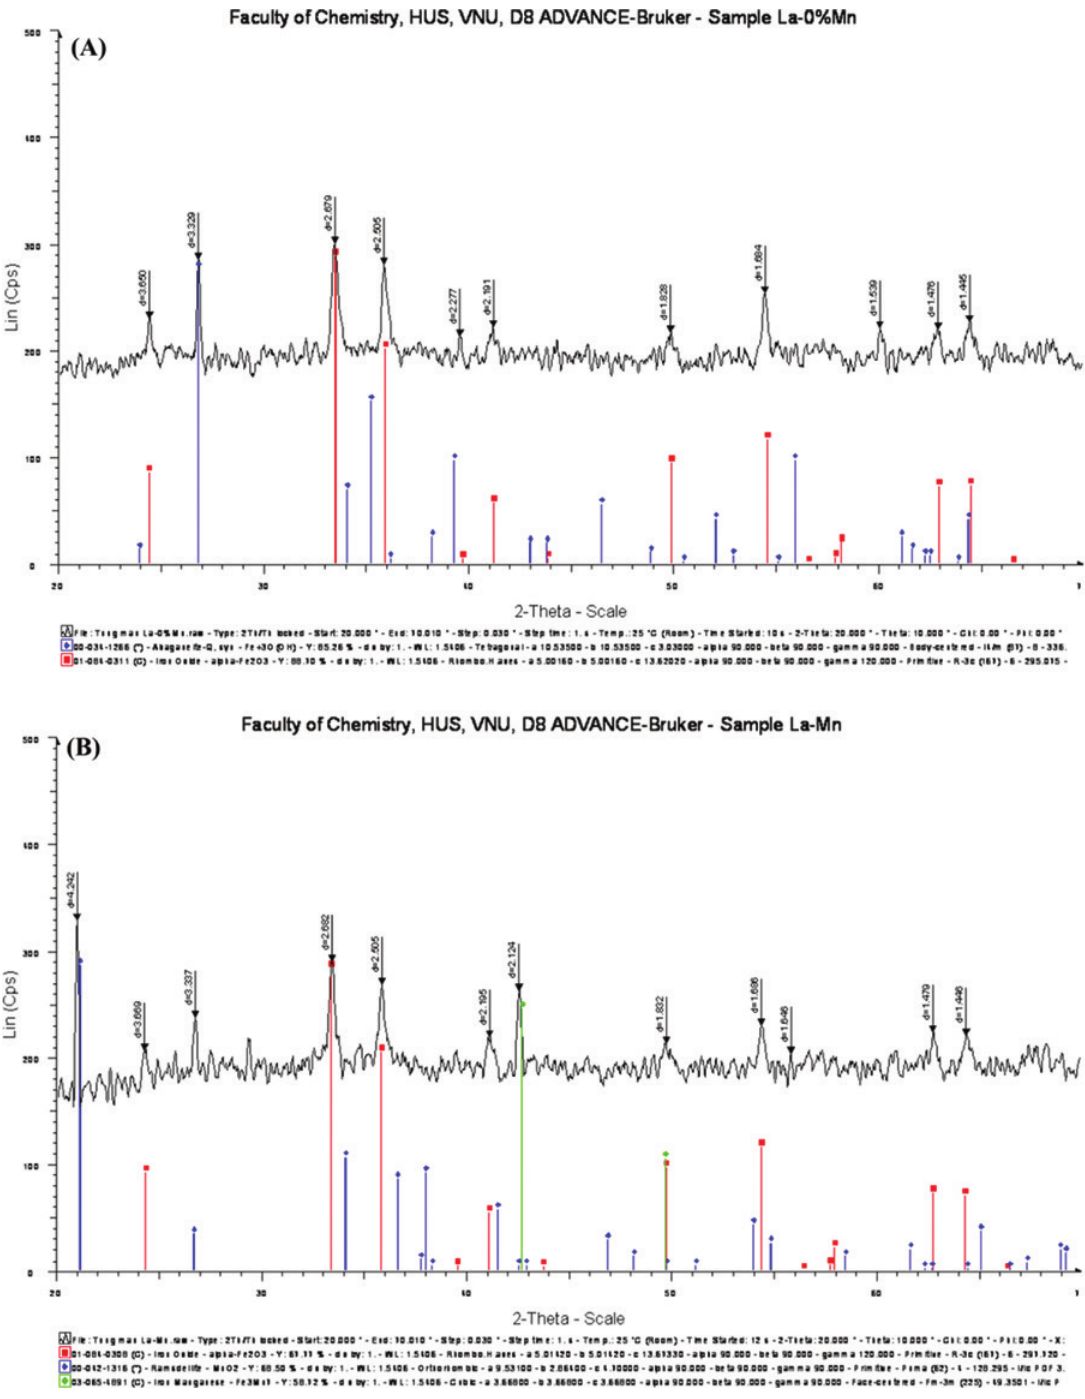
O ), (green peak) iron manganese (Fe 2 3